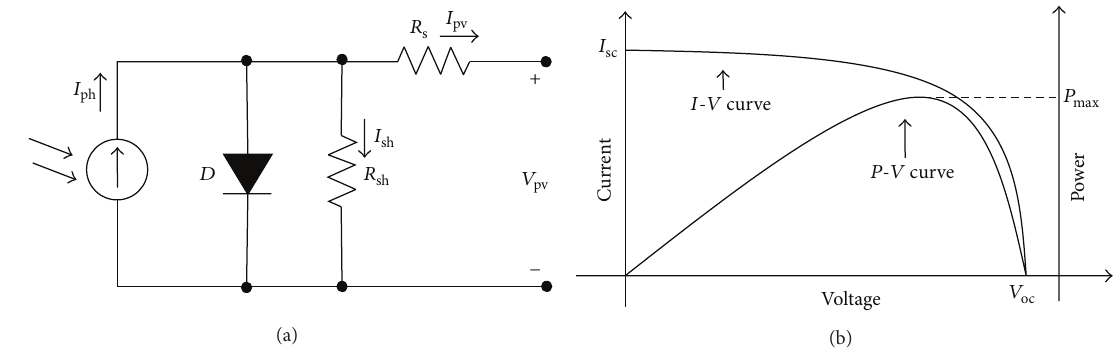
Figure 1: (a) Equivalent circuit model of a solar cell. (b) Solar cell 𝐼 - 𝑉 and power operation curve with the characteristic of 𝑉